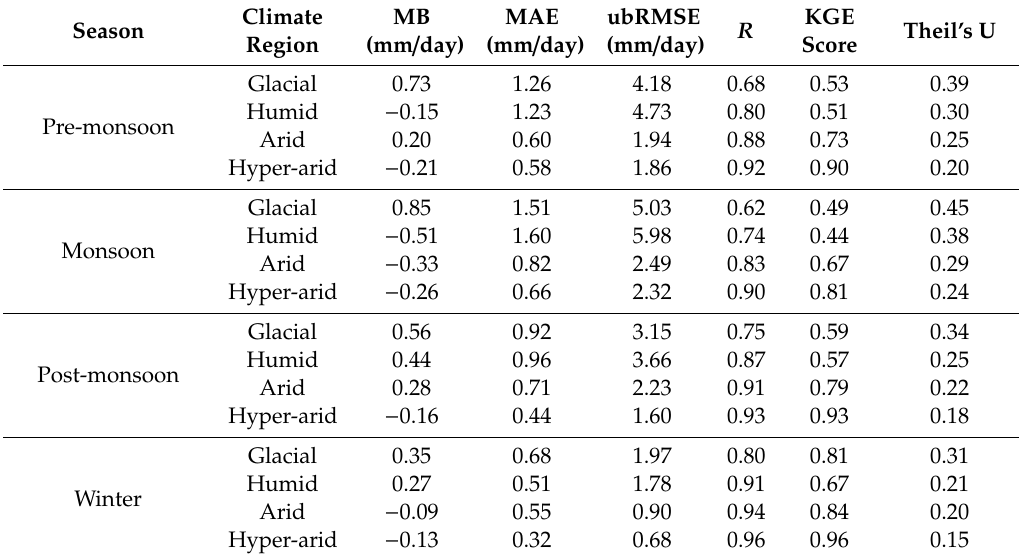
Theil’s U Score